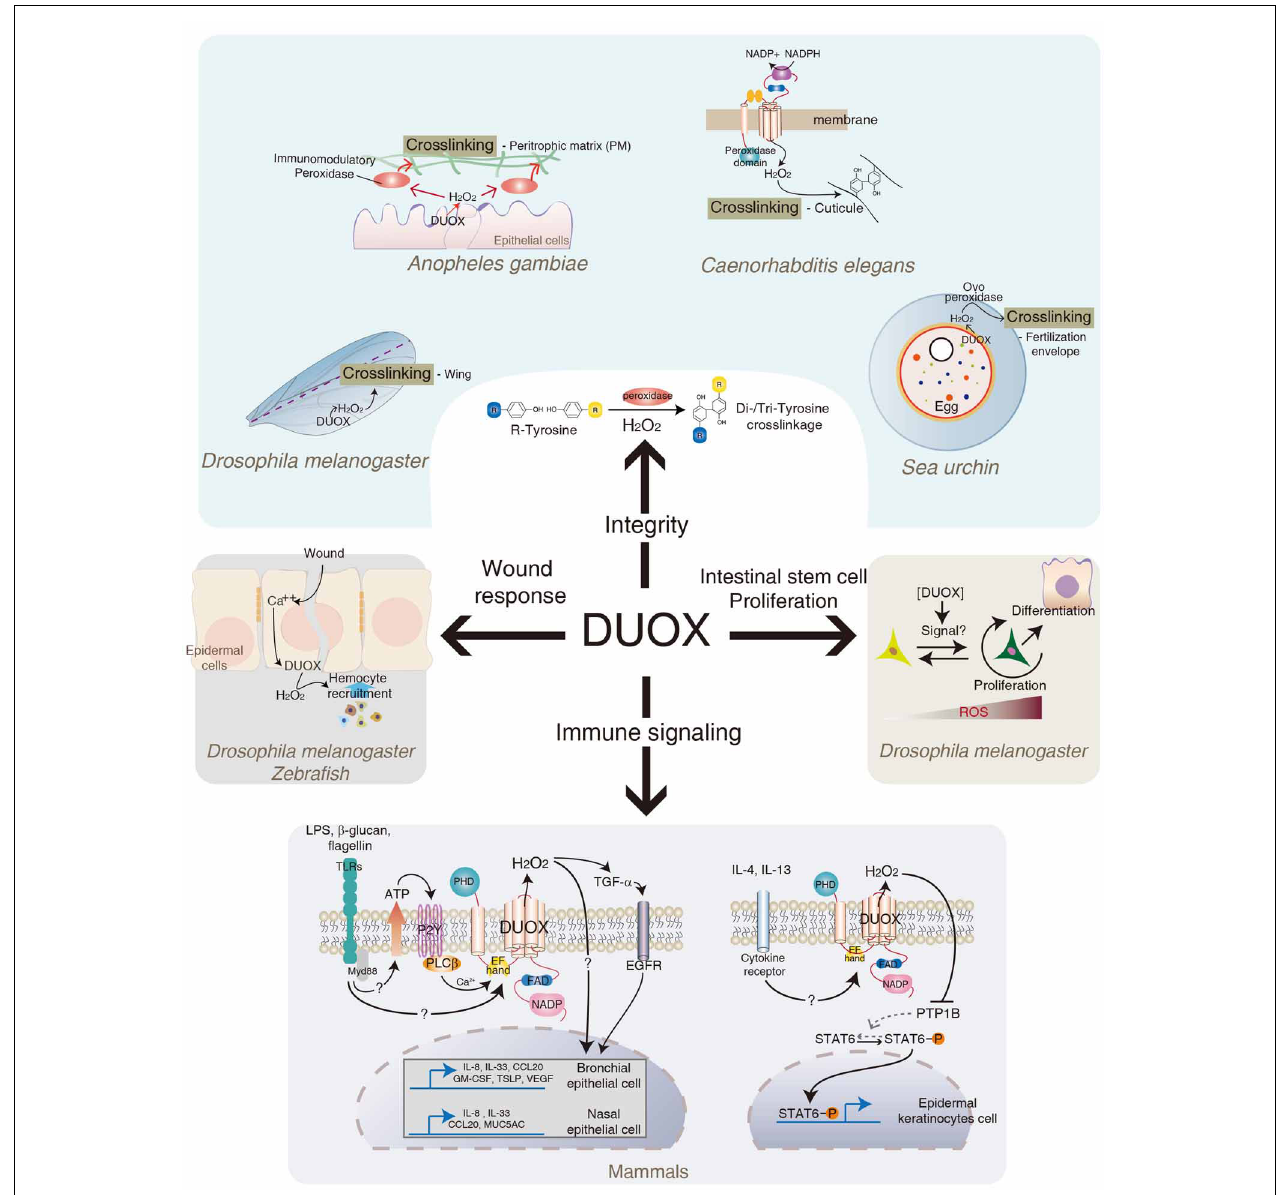
FIGURE 3 | Role of DUOX in diverse biological activities. In addition to its original function in redox-dependent antimicrobial defense in mucosa described in Figures 1 , 2 . DUOX system is also involved in cross-linking of